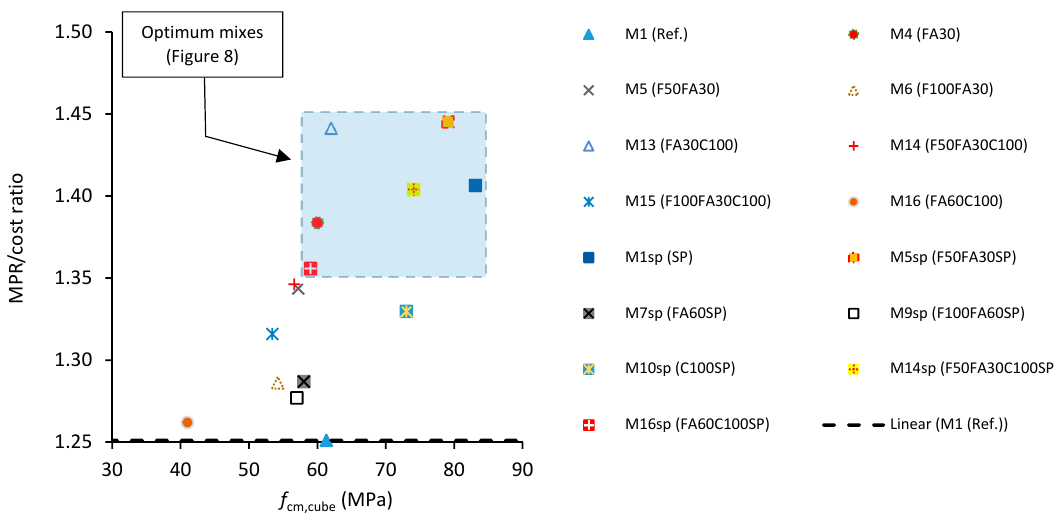
Figure 10. Compressive strength versus “MPR–cost ratio” of the concrete mixes.